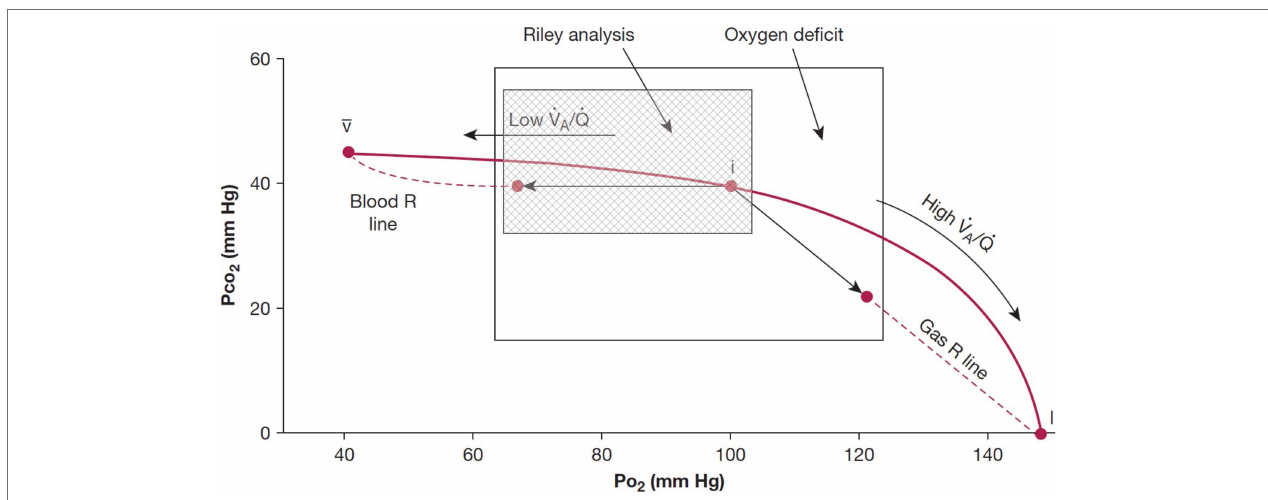
FIGURE 2 | Classic O 2 -CO 2 diagram with the ventilation-perfusion line joining the points for mixed venous blood and inspired gas. The traditional Riley analysis is based on the composition of arterial blood and ideal alveolar gas, and it is strongly biased by lung units with low ventilation-perfusion ratios that lie to the left of the ideal point (hatched area). By contrast, the new test also includes contributions from lung units with high ventilation-perfusion ratios that are located to the right of the ideal point. Modified from West et al.